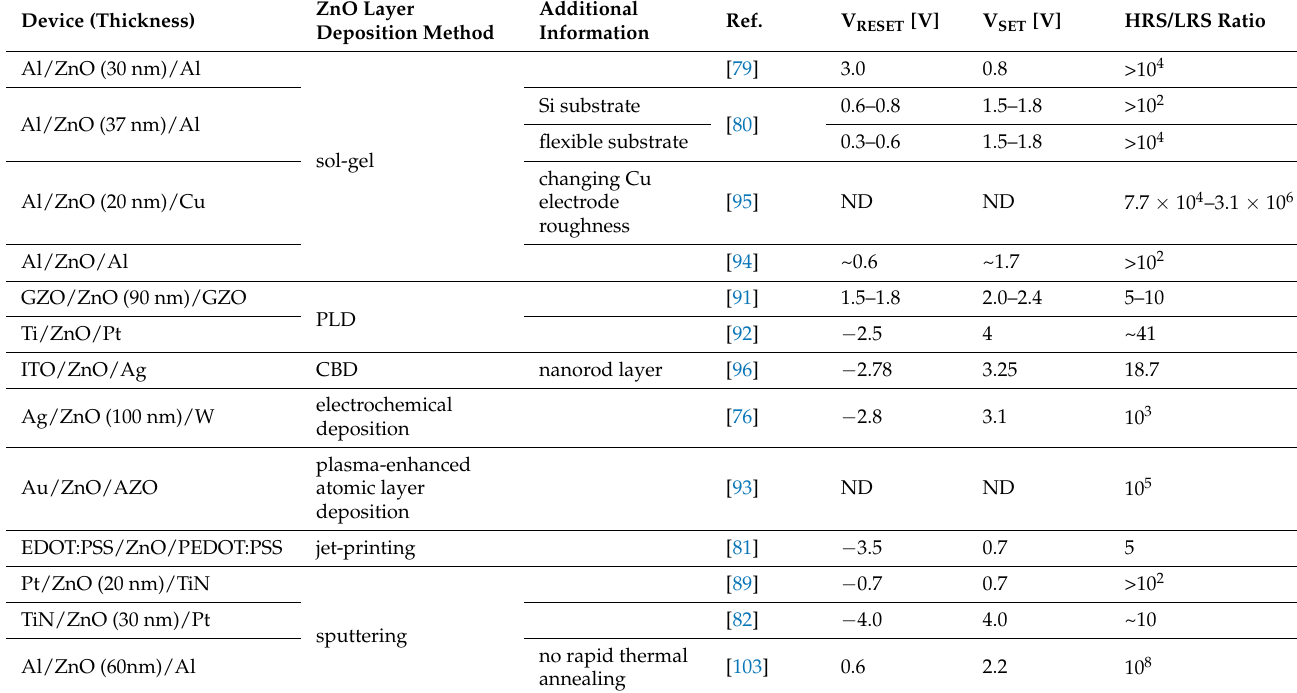
Table 1. Comparison between selected RRAM devices, ND—no